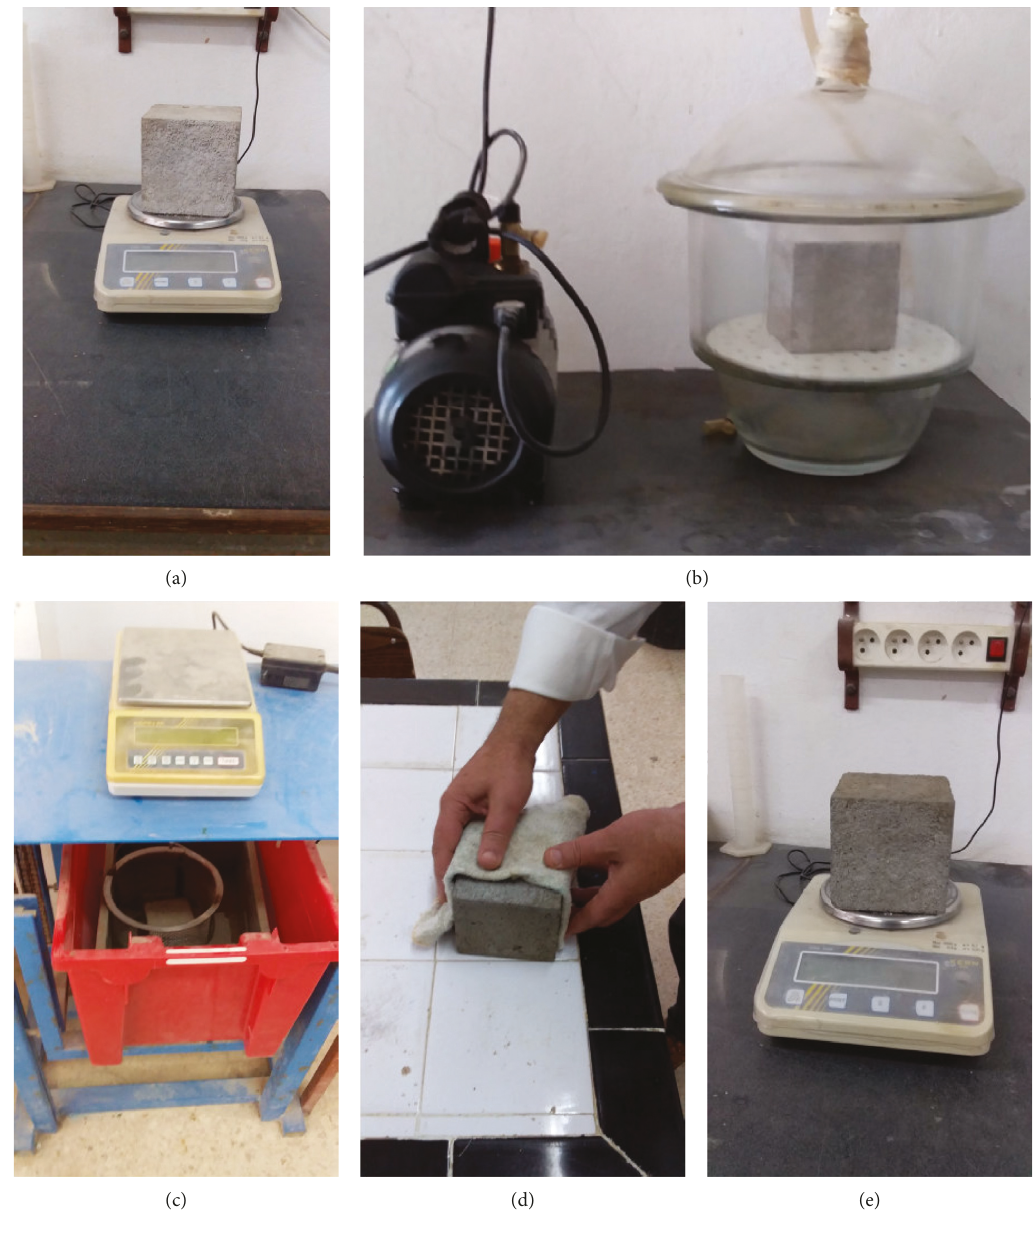
Figure 5: Steps of the porosity measurement test. Table 6: Effect of SWM dosage on the compressive strength of LC at 3, 7, and